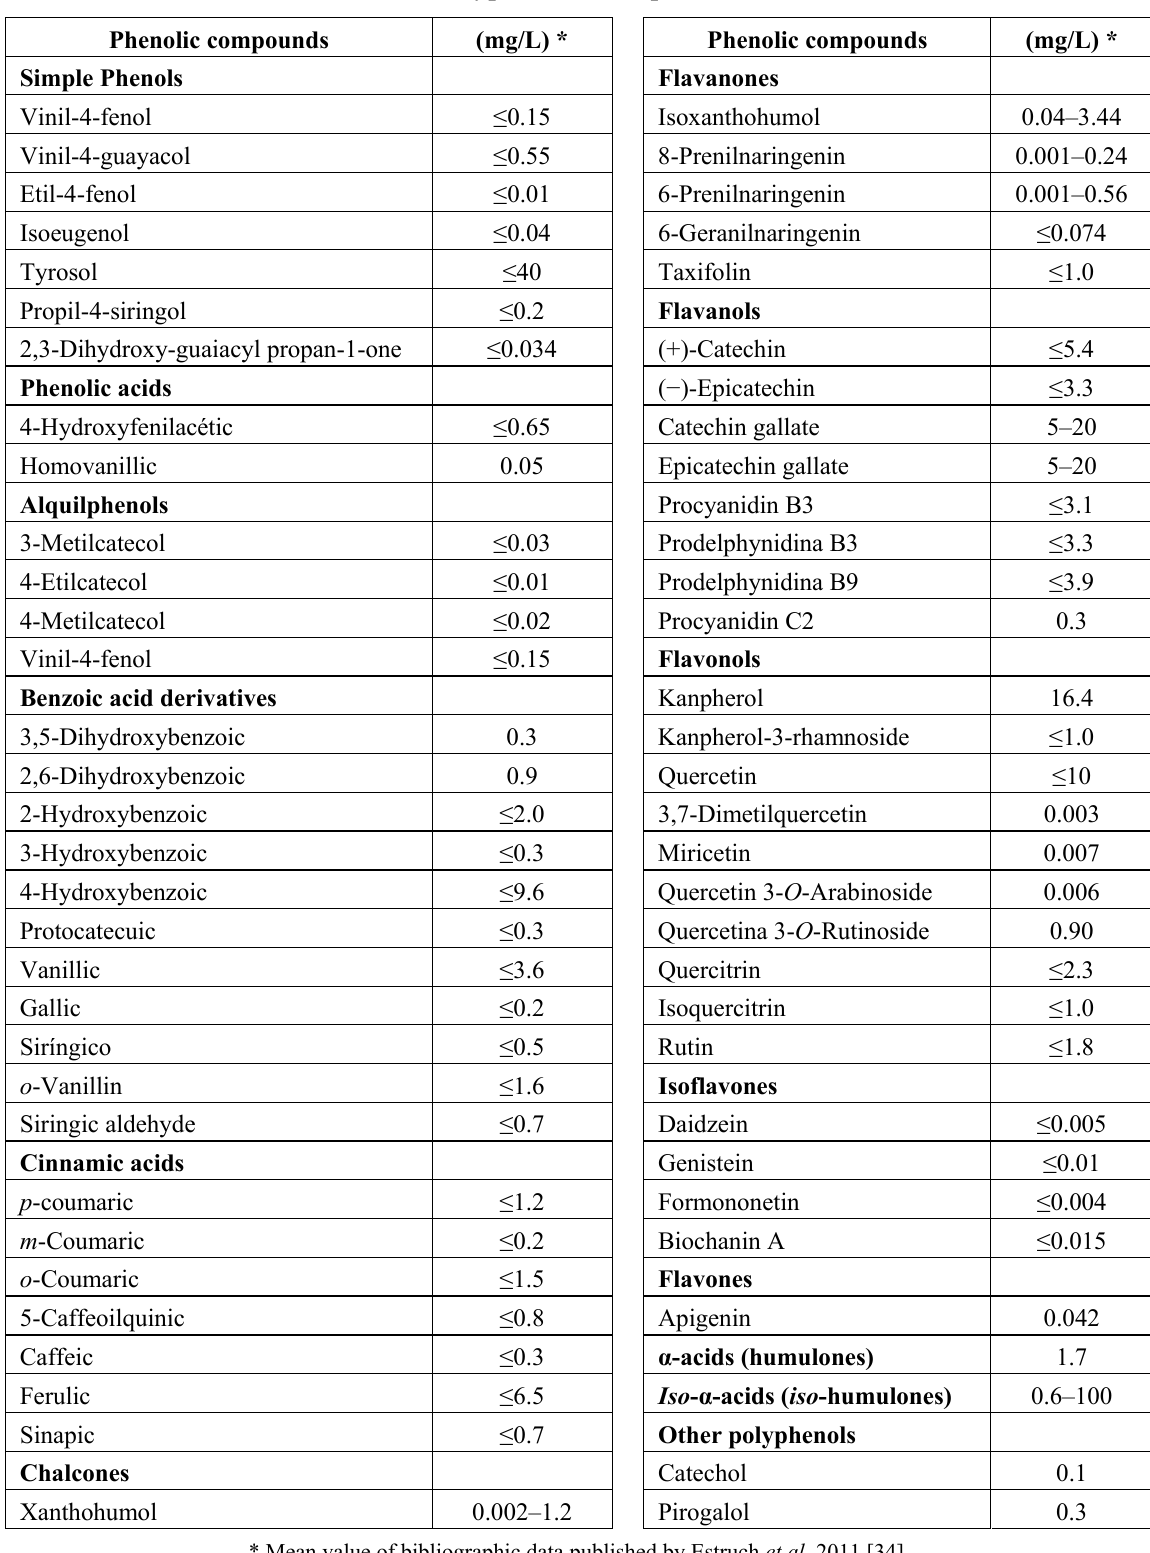
Table 2. Polyphenolic compounds in